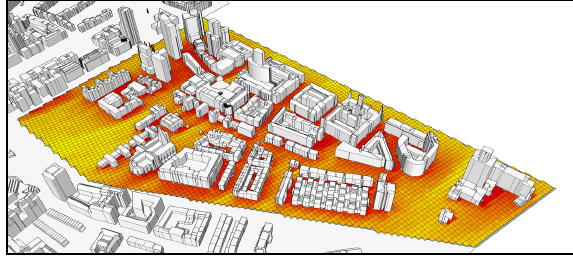
Figure 9. Representation of Average Insolation Time (AIT) for area in Rotterdam city centre by sunhours calculation (cityGML